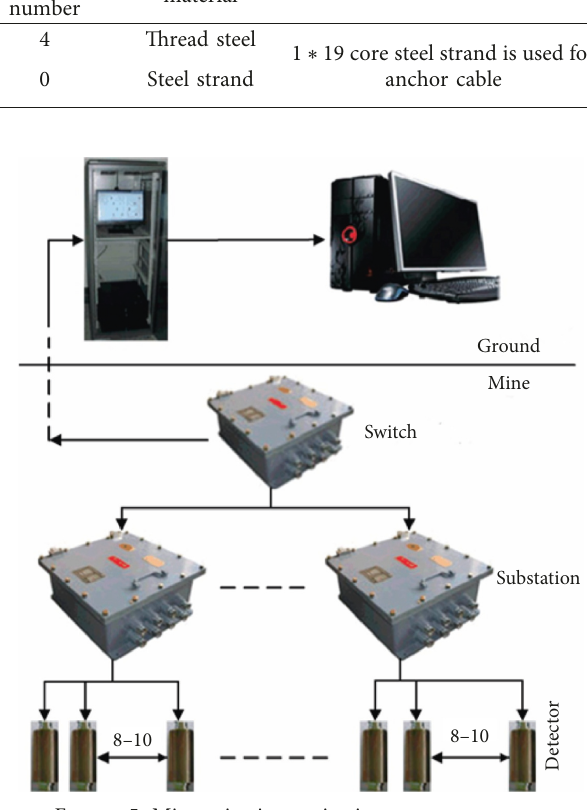
Figure 5: Microseismic monitoring system